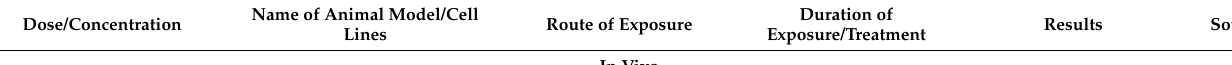
Effects of curcumin on cadmium toxicity based on doses, experimental methods, and